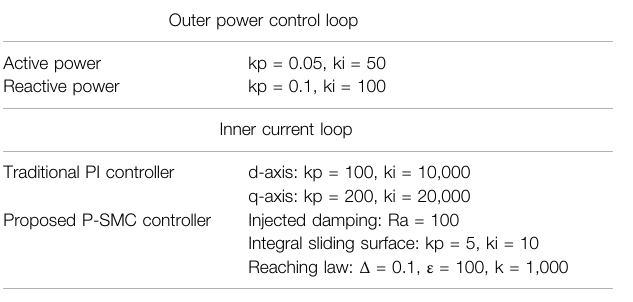
TABLE 3 | Main control parameters.